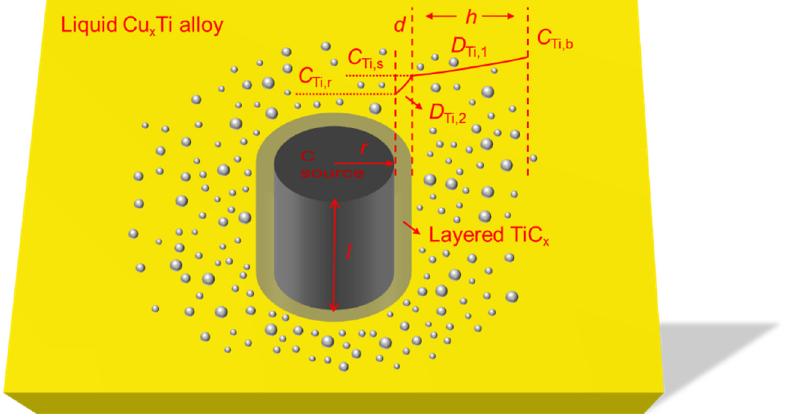
Figure 2. The schematic diagram of reaction mechanism of cylindrical solid C source particles in Cu-Ti melt.